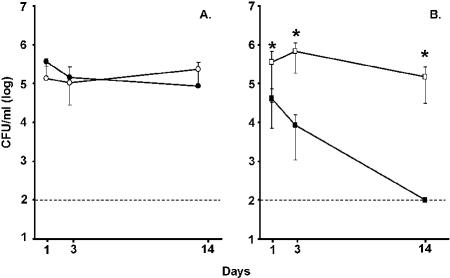
Colonization of BALB/c SCID Mice by H. influenzae Strain Hi636 and S. pneumoniae Strain Sp1121The mean density of H. influenzae strain Hi636 (A) and S. pneumoniae strain Sp1121 (B) in upper respiratory tract lavage ± standard deviation was determined on the day indicated following intranasal inoculation with 1 × 107 CFU of either one (open symbols) or both species (solid symbols). * p < 0.01 compared to co-colonization. Dashed line denotes the lower limit of detection.